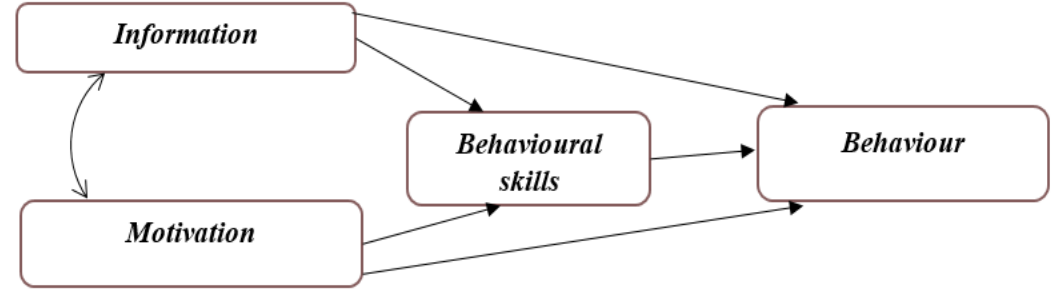
Figure 2. The Information–Motivation–Behavioral Skills Model (IMB). The theory focuses on three components, resulting in a behavioral change. Relevant information leading to the desired behavior, proper motivation to bring about such behaviors, then individuals are equipped with the required skills and abilities to carry out the desired actions.